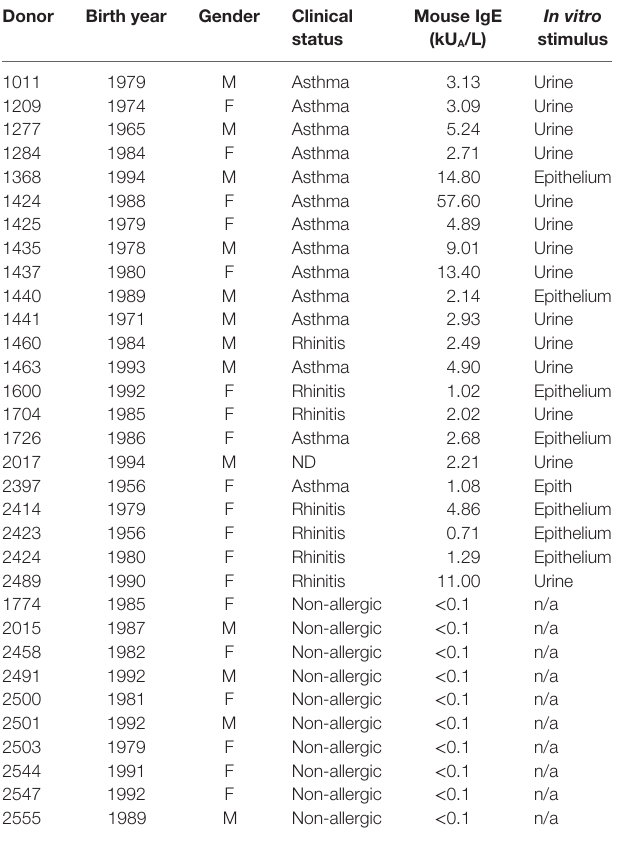
Table 1 | Clinical and demographic data for all donor